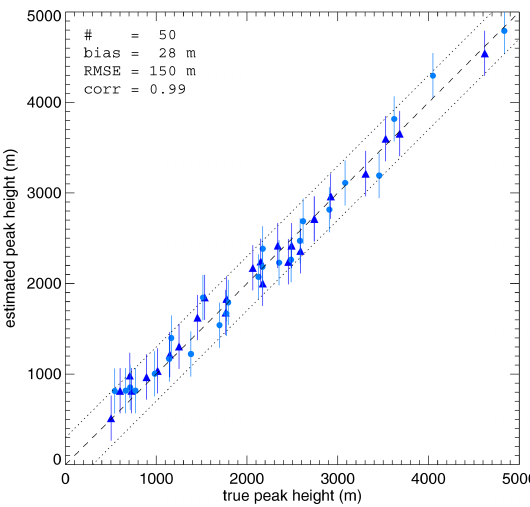
Figure 9. Peak height estimated by the side view method versus true peak height; two different colors and symbols are used only to help distinguish overlapping data points. The dashed line is the 1:1 line, and the dotted lines mark ± 2 × RMSE about the 1:1 line. The error bars on a data point represent the standard deviation of the nine height estimates corresponding to the visually identified peak location and its 8-pixel